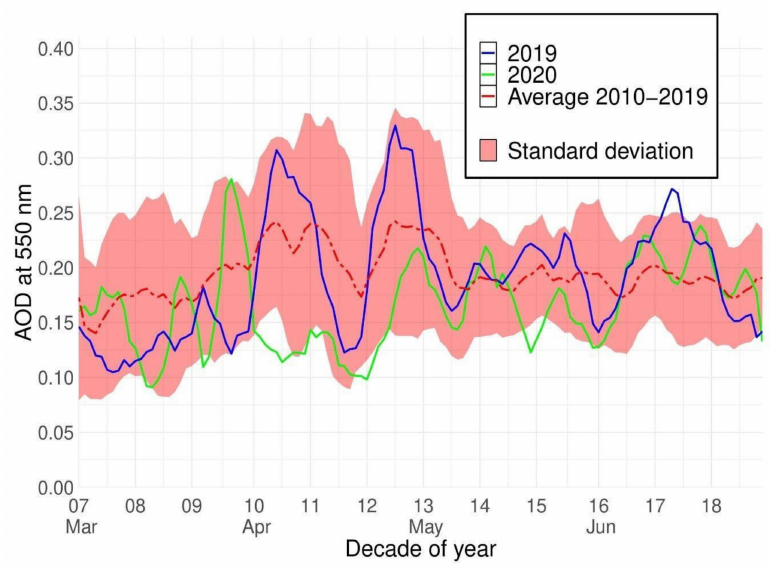
Figure 4. Temporal variability of 5-day running means of total AOD at 550 nm over Poland obtained from MERRA-2 reanalysis. Blue, green and red lines show data for 2019, 2020 and 2010–2019, respectively. The pink shadow indicates standard deviations of AOD for the 2010–2019